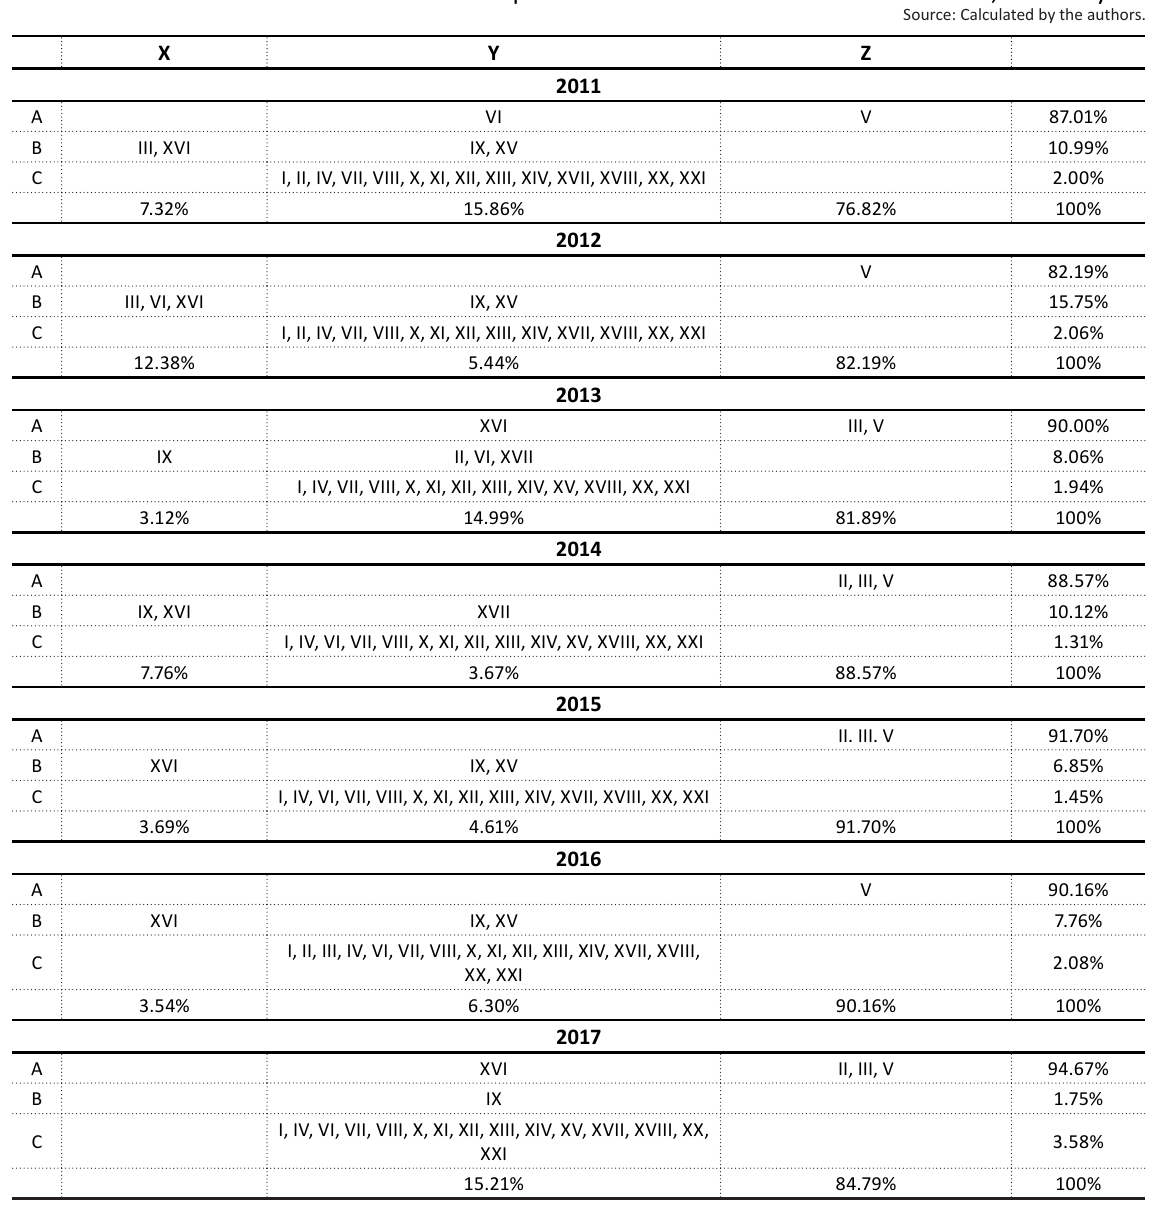
Source: Calculated by the authors.